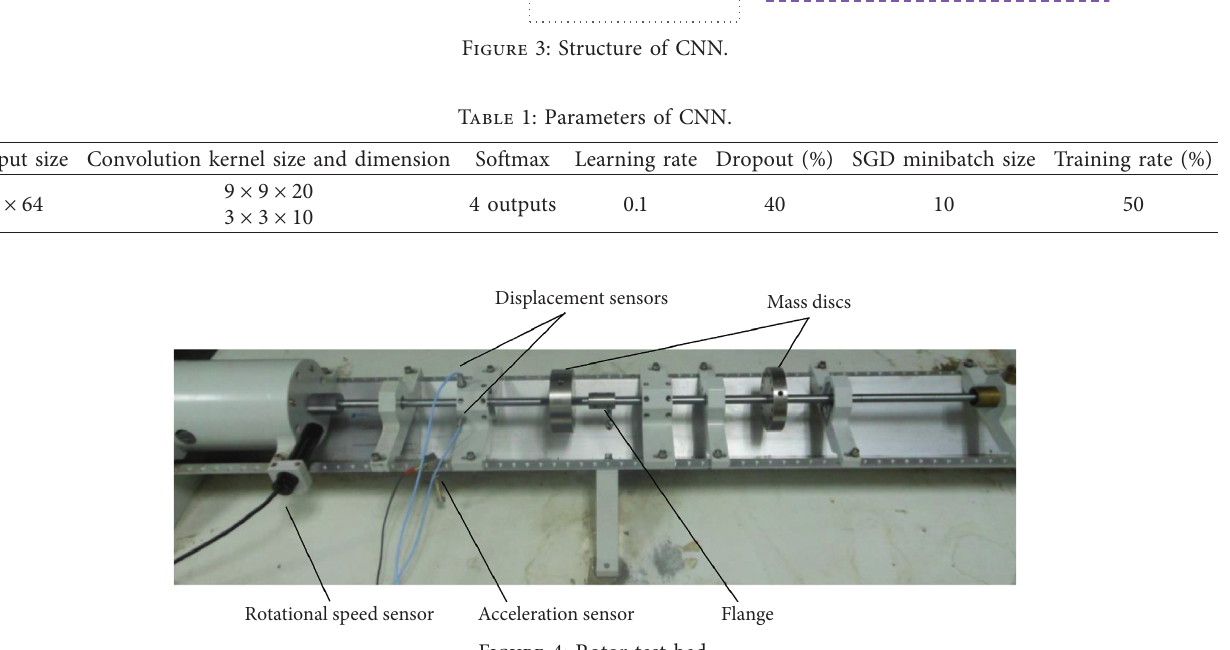
Figure 4: Rotor test